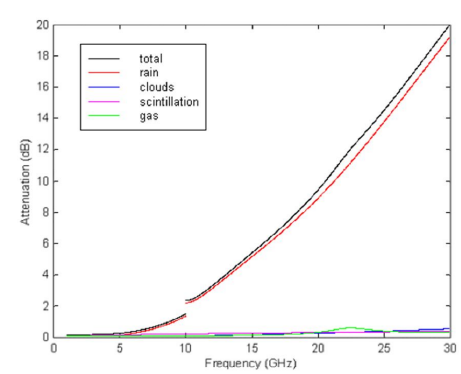
Figure 5. Components of the atmospheric attenuation versus the frequency for 0 . 01% of the time a magnitude of 20 dB for 0.05% of an average year in Ka band. It represents the most serious limitation to the performance of satellite communication links in the millimeter wave domain. In addition, second order statistics of rain attenuation should also be taken into account in the design of a satellite communication system, since they directly relate to outage durations. Amplitude scintillation manifesting itself in the form of rapid signal fluctuations. Scintillation may impact the long term system availability (time percentages higher than